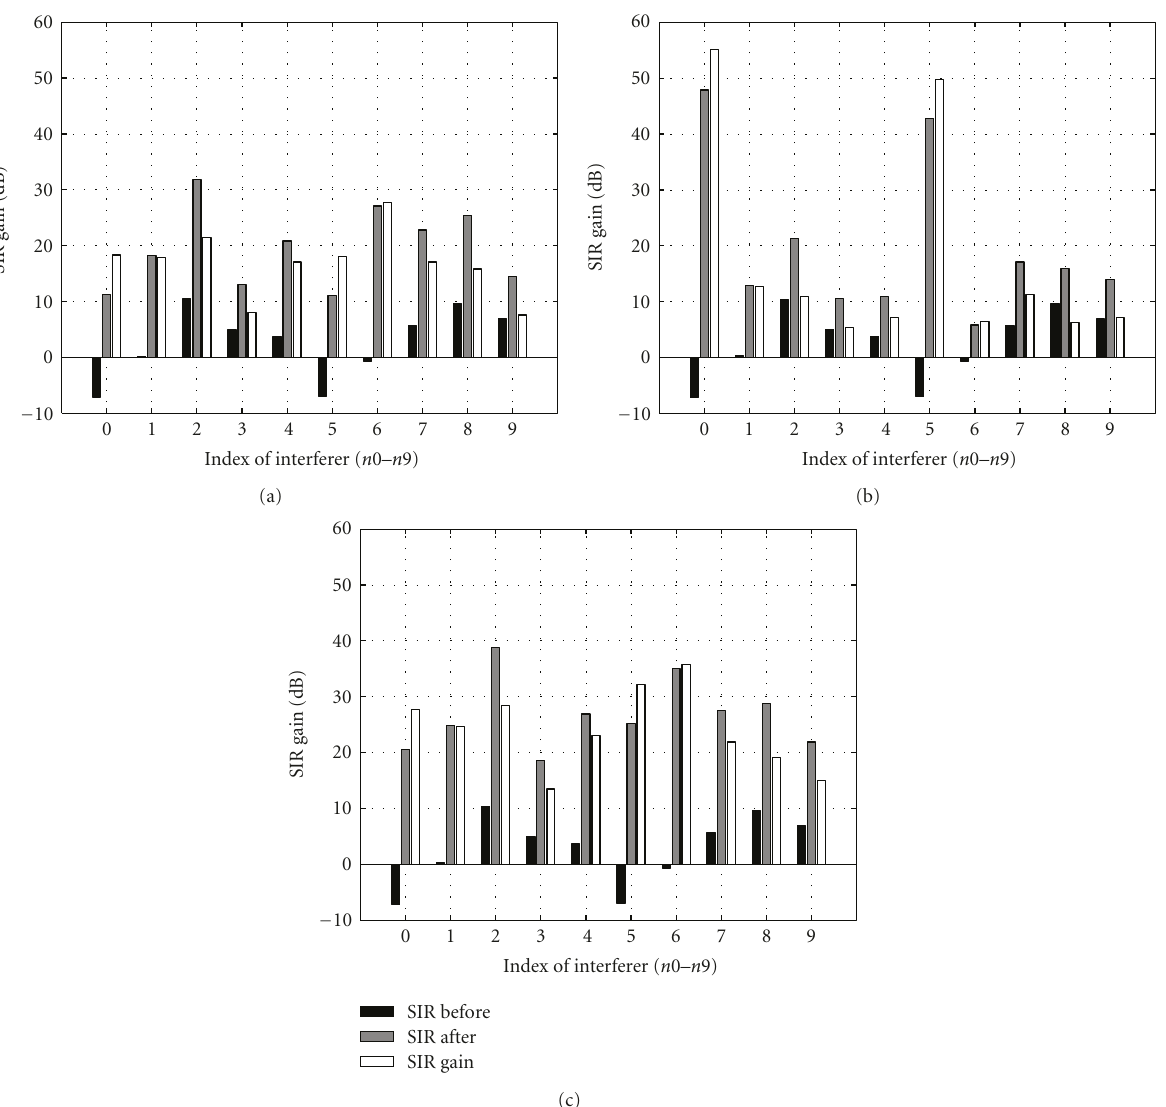
Figure 6: SIR gains of (cid:30) v 8 estimates from beamforming (a), CASA (b) and CASA-EB (c). The horizontal axes in the graphs specify the test mixture by the index of the interferer. The three bars shown for each indicate the SIR of v 8 in the mixture (black), the SIR of the separated (cid:30) v 8 (gray), and the SIR gain (white). To summarize these results, the mean SIR gains are 16.9 dB (for beamforming on mixtures with π/ 2 radians of source separation), 17.2 dB (for monaural CASA) or 8.4 dB (for monaural CASA without the n 0 and n 5 results), and 24.2 dB (for CASA-EB on mixtures with π/ 2 radians of source